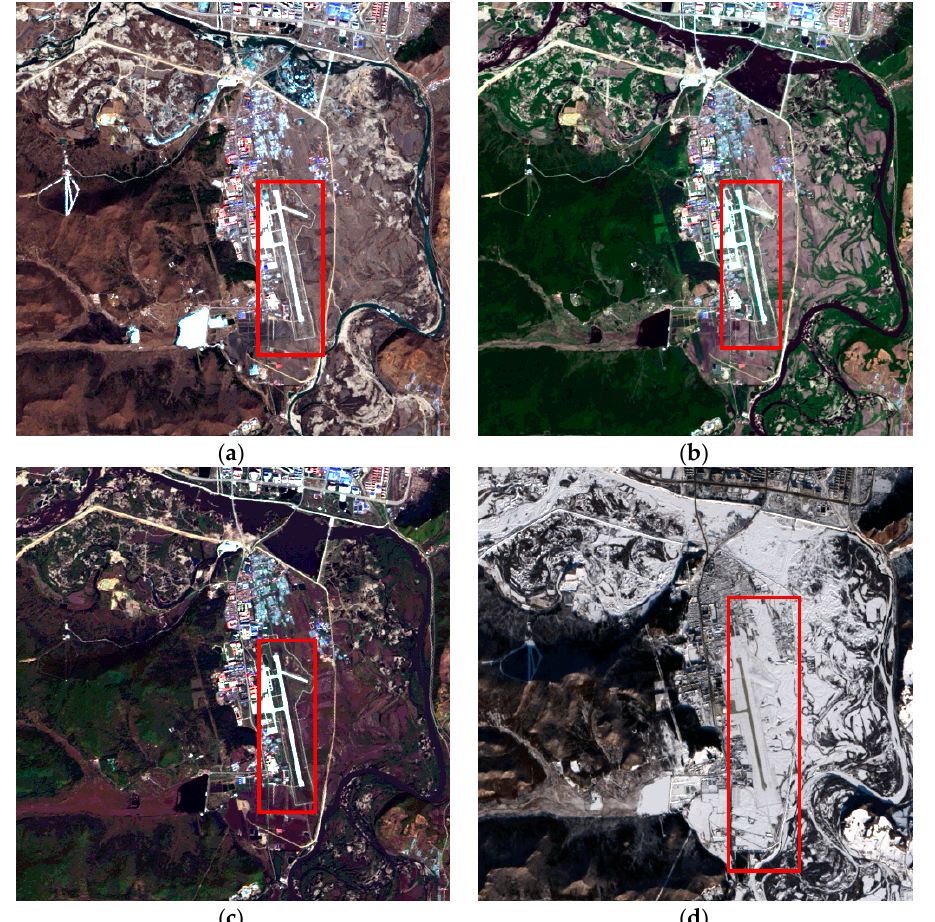
Figure 16. Detection results of the original Faster R-CNNalgorithm in different seasons at Jiagedaqi airport. ( a ) 15 April 2014; ( b ) 14 June 2015; ( c ) 20 September 2016; ( d ) 16 December 2016.